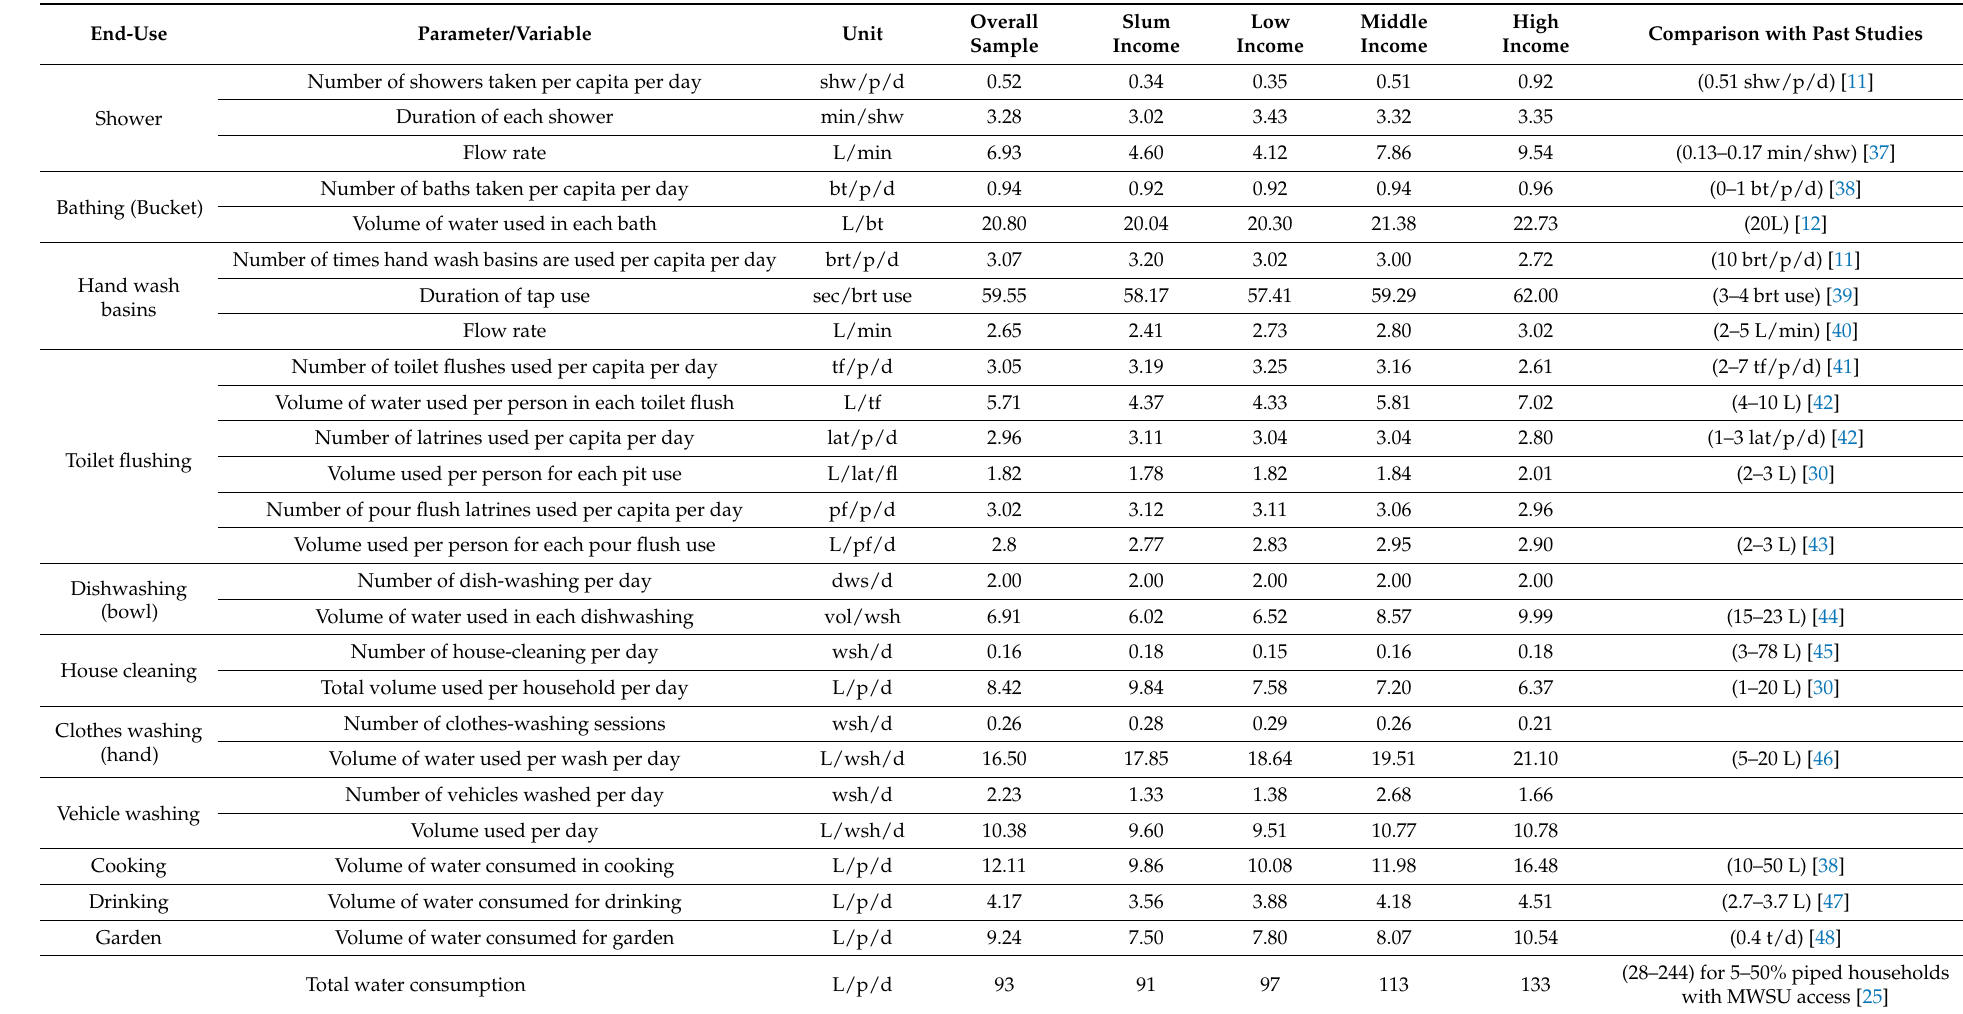
Table 4. Summary of mean values of water end-use parameters (398